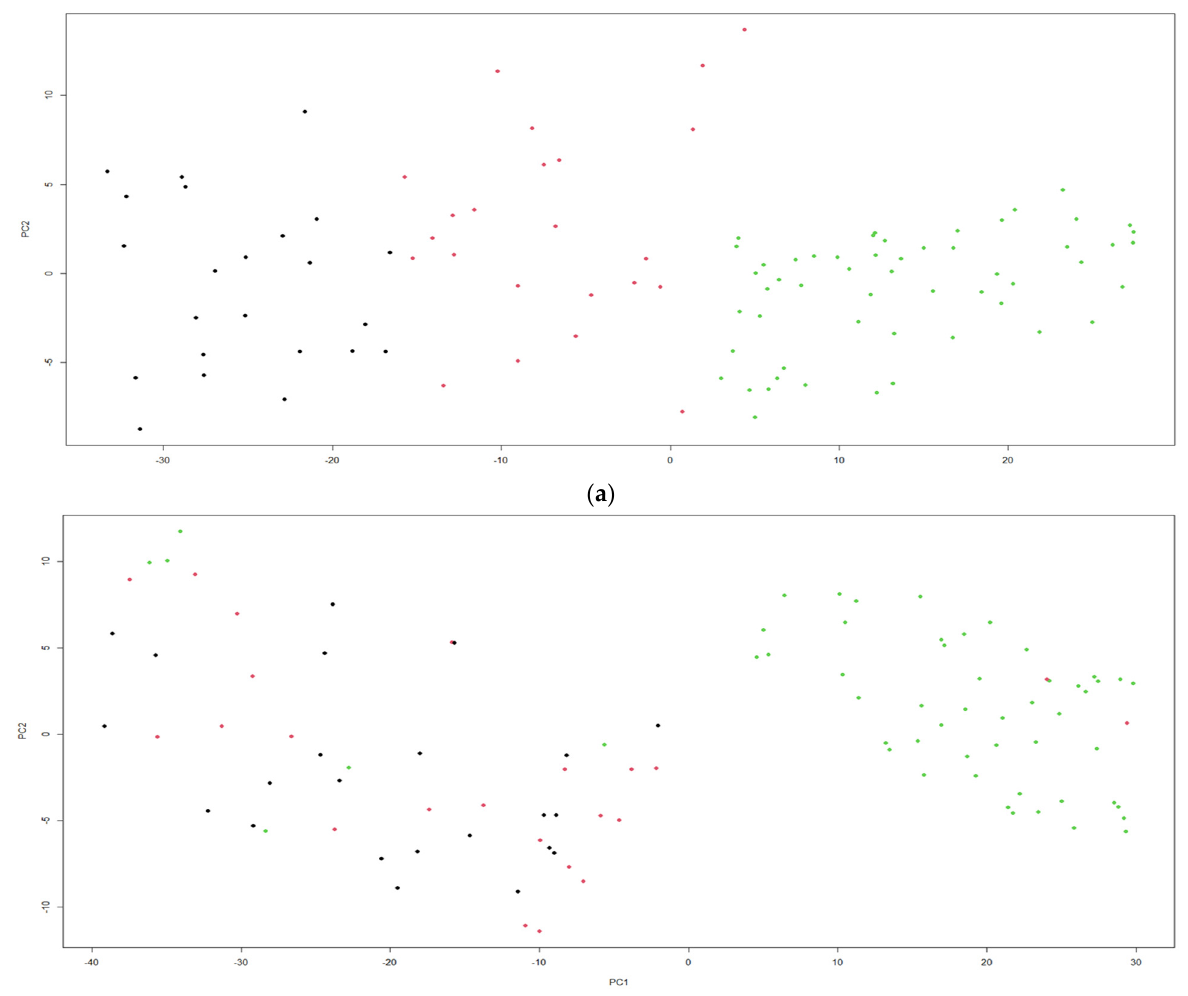
Figure 1. ( a ) K − means using 3 clusters for productivity parameters of Pleurotus ostreatus cultivated on two mixtures of agricultural wastes, ( b ) K − means using 3 clusters for productivity parameters of Pleurotus djamor cultivated on two mixtures of agricultural wastes.